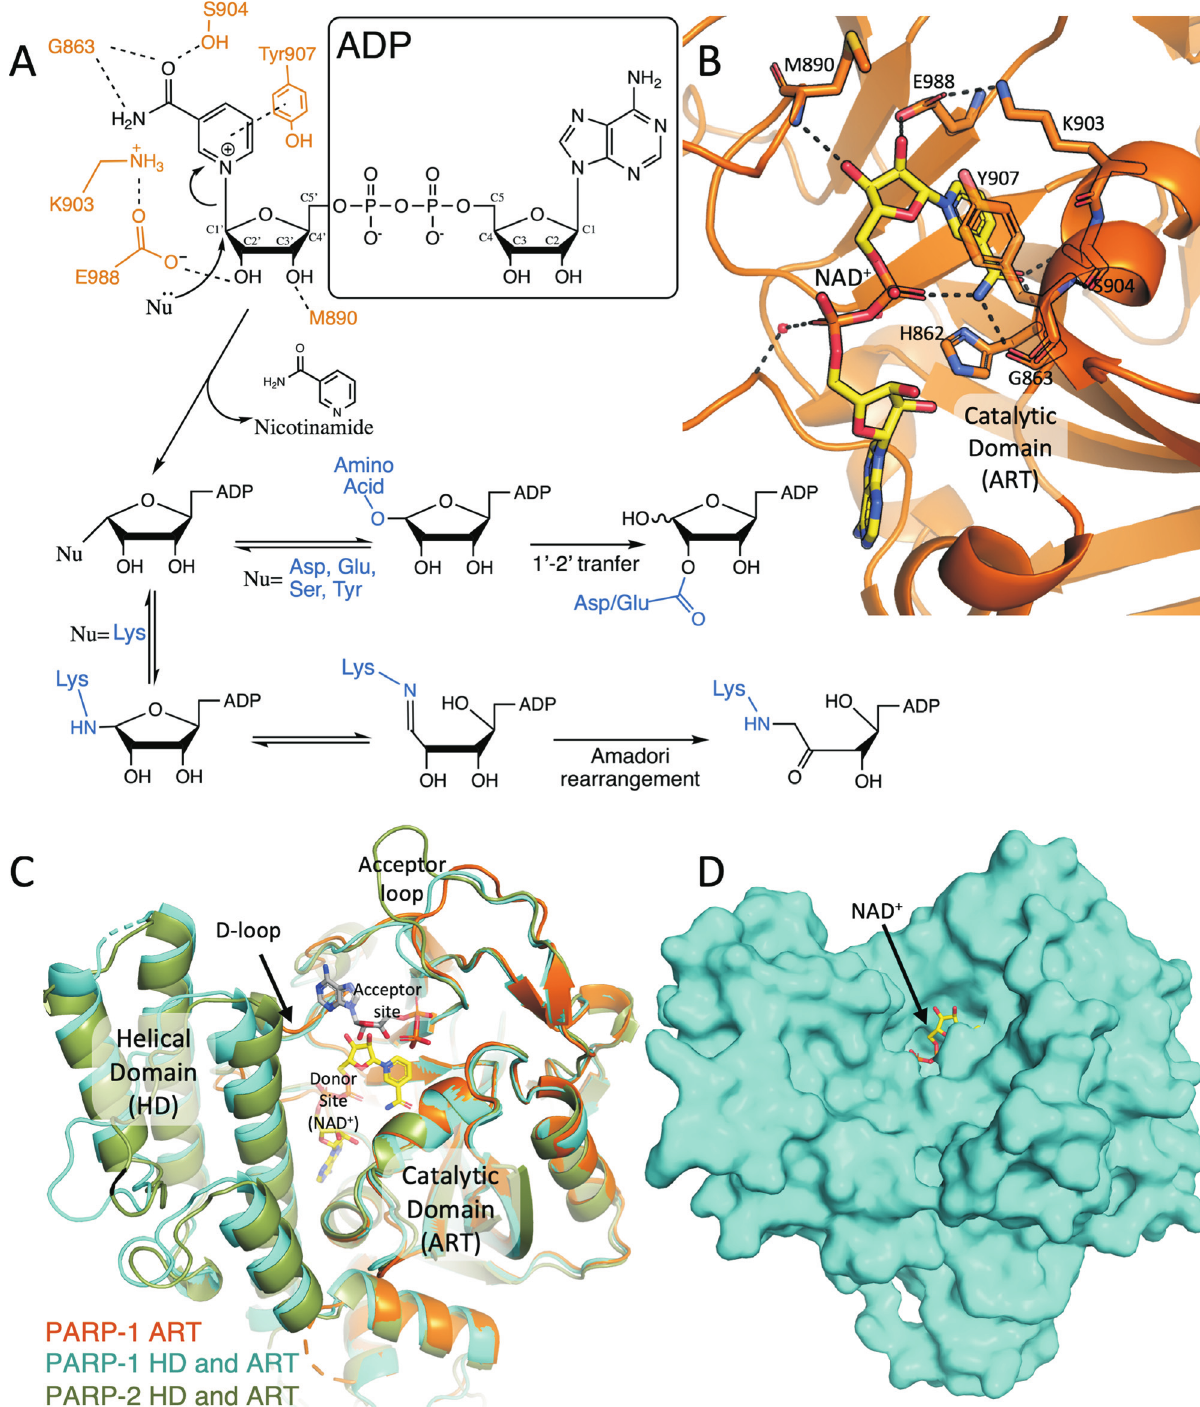
Figure 1 - Schematic mechanism of ADP ribosylation reaction and the catalytic domain of DNA-dependant PARPs. A) A simplified overview of the (ADP)-ribosylation reactions catalysed by PARPs. The final products depend on the acceptor residue acting as a nucleophile (Nu, in blue). PARP1 ac- tive-site residues interacting with the ribose-nicotinamide moiety of NAD + are illustrated in orange. B) The NAD + (modelled based on the human PARP1 bound to benzamide adenine dinucleotide [PDB: 6BHV], carbon atoms in yellow) in an extended conformation, bound to the catalytic domain of human PARP1 (ART in cartoon, orange, [PDB: 6BHV]). The residues involved in the catalysis are presented as sticks. C) Superposed cartoon view of human PARP-1 ART domain (orange, [PDB: 6BHV]), PARP1 (light blue, [PDB: 5WS1]) and PARP2 (green, [PDB: 3KJD]) showing the structure of the entire catalytic domains (ART and HD). The modelled NAD + (in yellow) denotes the donor site, while a molecule of ADP (modelled by superimposing the structures of chicken PARP1 [PDB: 1A26] to the human PARP1 [PDB: 3KJD]) indicates the acceptor site. Donor loop (D-loop) and acceptor loop are la- belled. D) Surface representation of human PARP1 [PDB: 3KJD] with NAD + modelled into the active site. The ribose group to be attacked is exposed to the